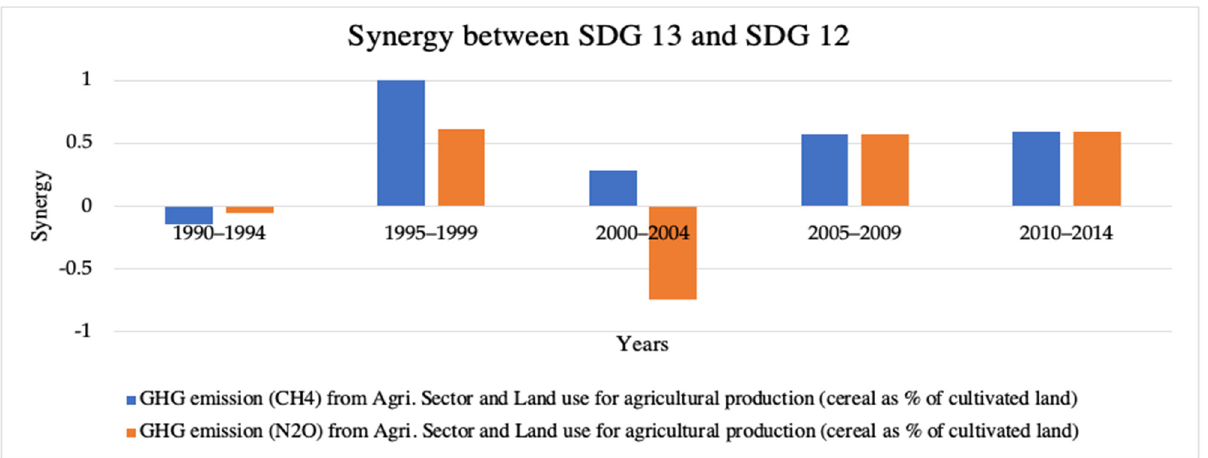
Figure 16. Synergy: GHG emission (CH 4 , N 2 O) from Agricultural Sector and Land Use for Agricul- tural Production (cereal as % of cultivated land).